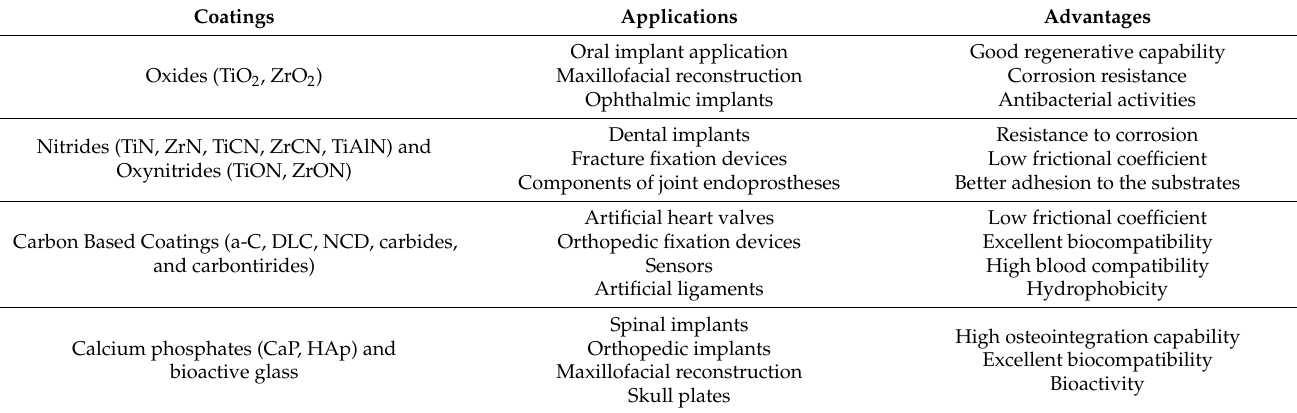
Table 1. Ceramic coatings used for biomedical applications